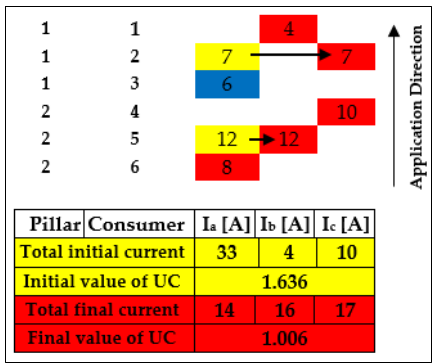
Figure 6. The mechanism of proposed algorithm and the obtained results.